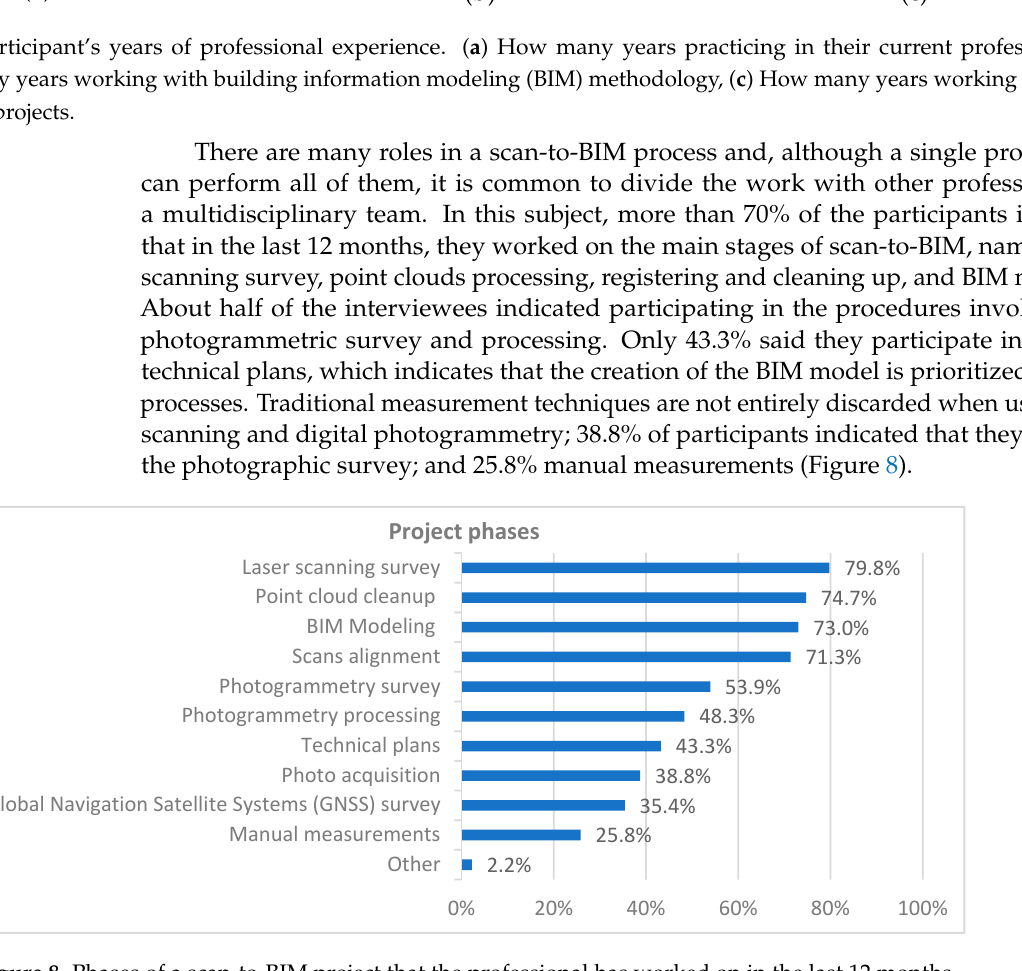
Figure 8. Phases of a scan-to-BIM project that the professional has worked on in the last 12 months.